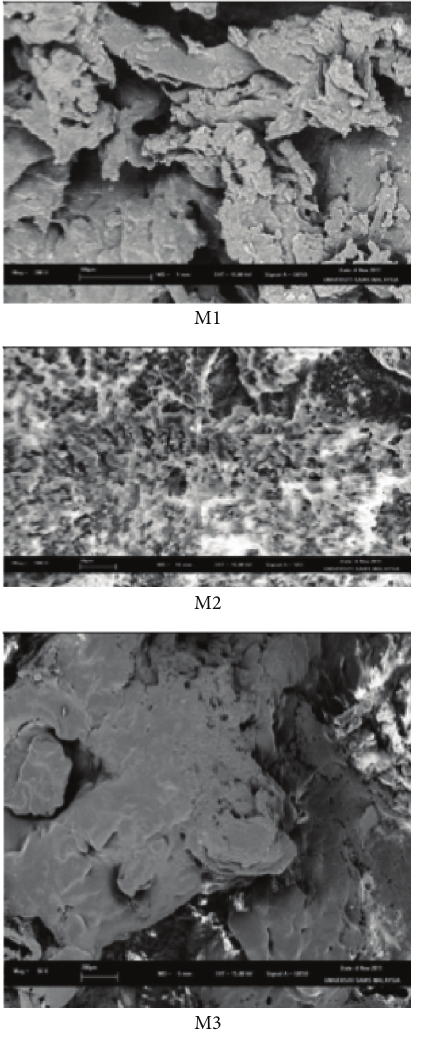
Figure 6: SEM micrographs of the prepared terpolymers M1, M2, and M3. Table 2: Mechanical properties of the primer cast films. Samples